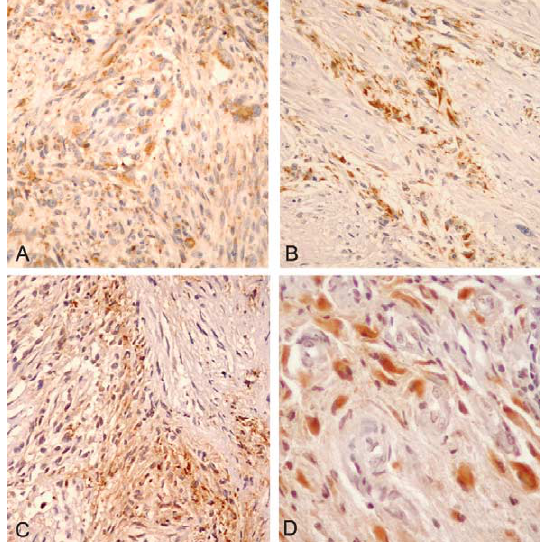
Fig. 2. Sequencing analysis of PDGFR - α : (A) insertion of a thymine (arrow) at position minus 50 of intron 17 (sense strand); and (B) cy- tosine to thymine substitution (arrow) at nucleotide 2472, resulting in silent mutation (antisense strand). The mutational analysis of B-RAF , c-kit and PDGFR - α genes in glioma-derived cell lines showed the ab- sence of B-RAF and c-kit mutations and the presence of the IVS17-50insT insertion at intron 17 of PDGFR - α in all cell lines. SW 1088 cell line was heterozygous for the inserted thymine, whereas A-172 and U-87 MG cell lines were homozygous for the insertion (data not shown). Although the intronic position of the insertion suggests no biological consequence, we investigated the possibility of splicing deregulation introduced